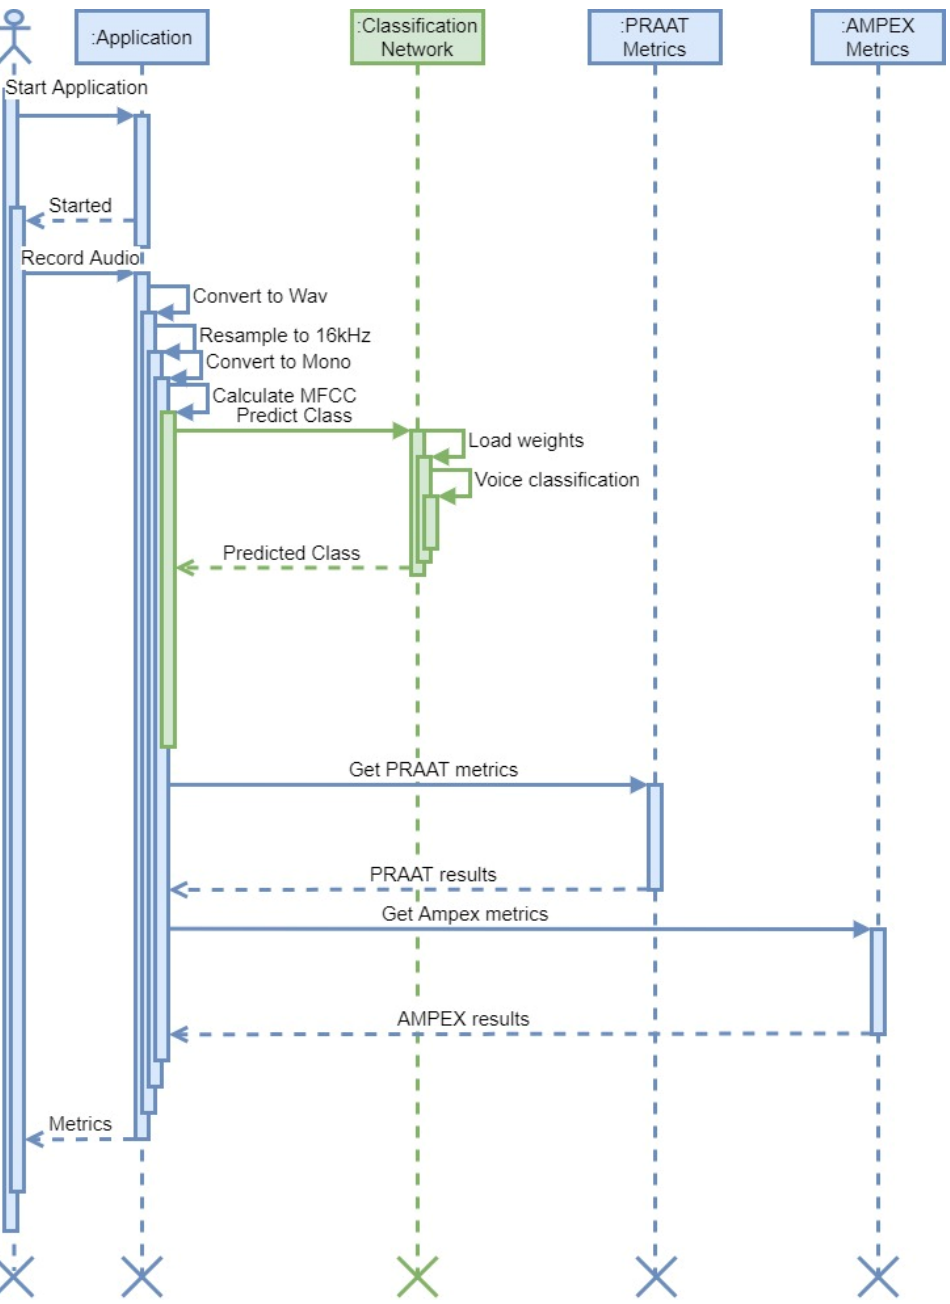
Figure 10. Activity UML diagram explaining the principle of implementation. Tasks performed by the neural network are highlighted in green.